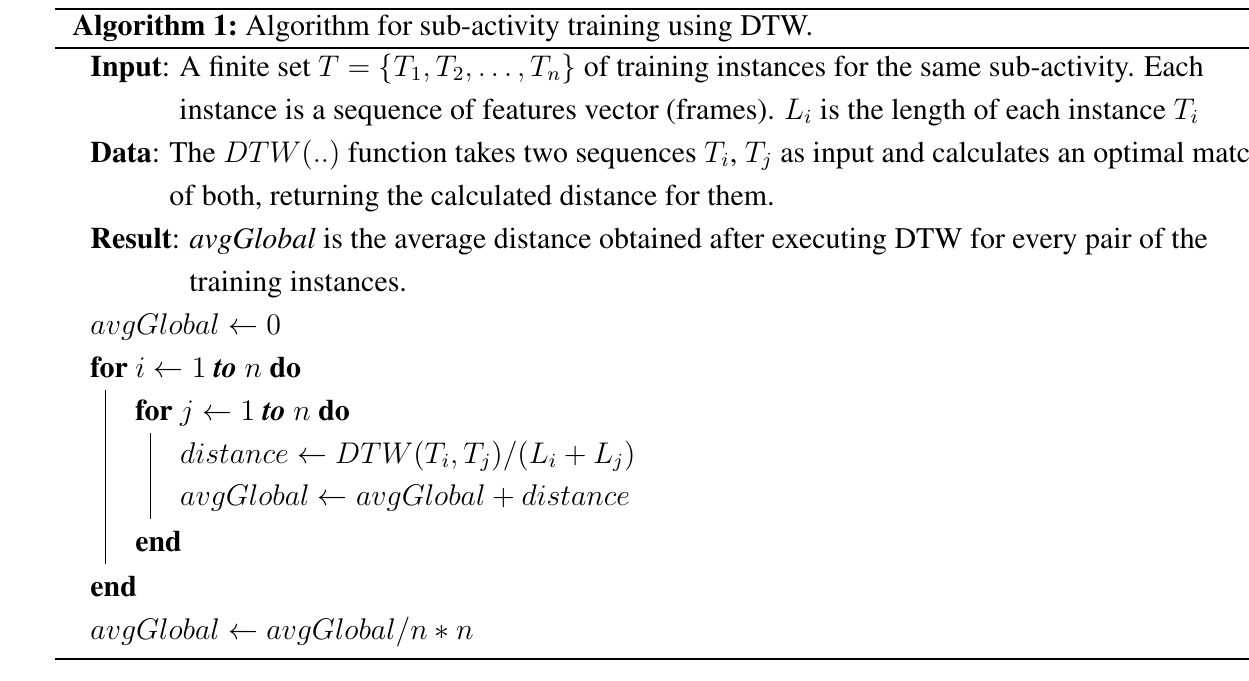
Algorithm 1: Algorithm for sub-activity training using